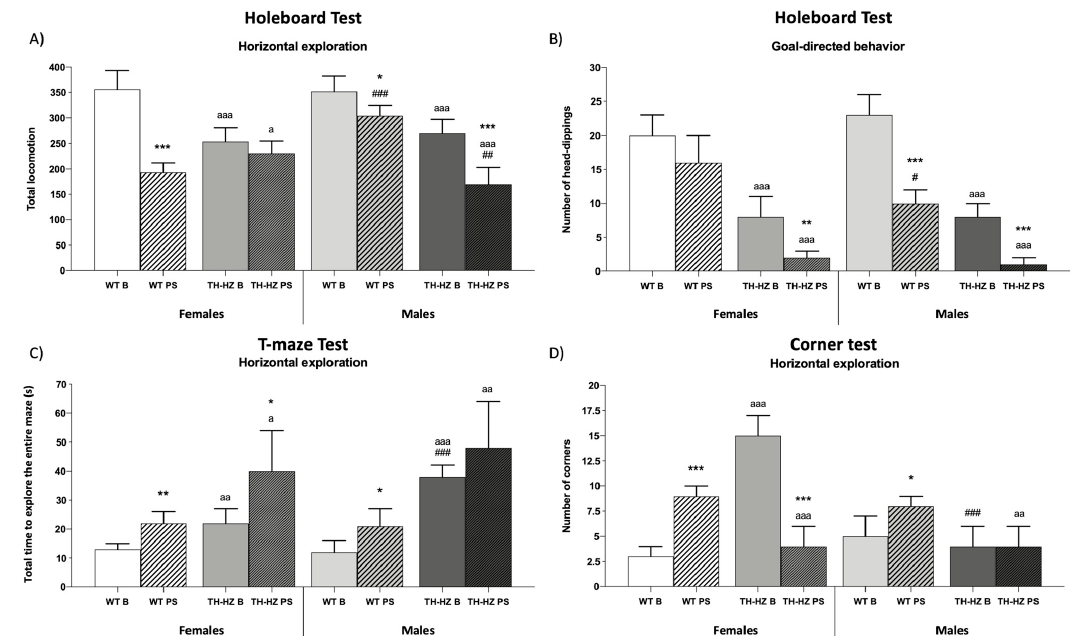
Figure 3. Exploratory behaviors. ( A ) Total locomotion in holeboard test (HBT). ( B ) Number of head-dippings performed in HBT. ( C ) Time (in seconds) to complete the entire T-maze. ( D ) Number of visited corners in the corner test. Each column represents the mean ± standard deviation of values corresponding to 6 animals. * p < 0.05, ** p < 0.01, *** p < 0.001 compared to basal condition, a p < 0.05, aa p < 0.01, aaa p < 0.001 compared to WT. # p < 0.05, ## p < 0.01, ### p < 0.001 compared to female. WT B: Wild type basal. WT PS: Wild type post-stress. TH-HZ B: TH-HZ basal. TH-HZ PS: TH-HZ post-stress. Table 1. Sensorimotor abilities and anxiety-like behaviors evaluated in female and male WT and TH-HZ mice in basal and post-stress conditions. Females Males WT WT TH-HZ TH-HZ WT WT TH-HZ TH-HZ Basal Post-Stress Basal Post-Stress Basal Post-Stress Basal